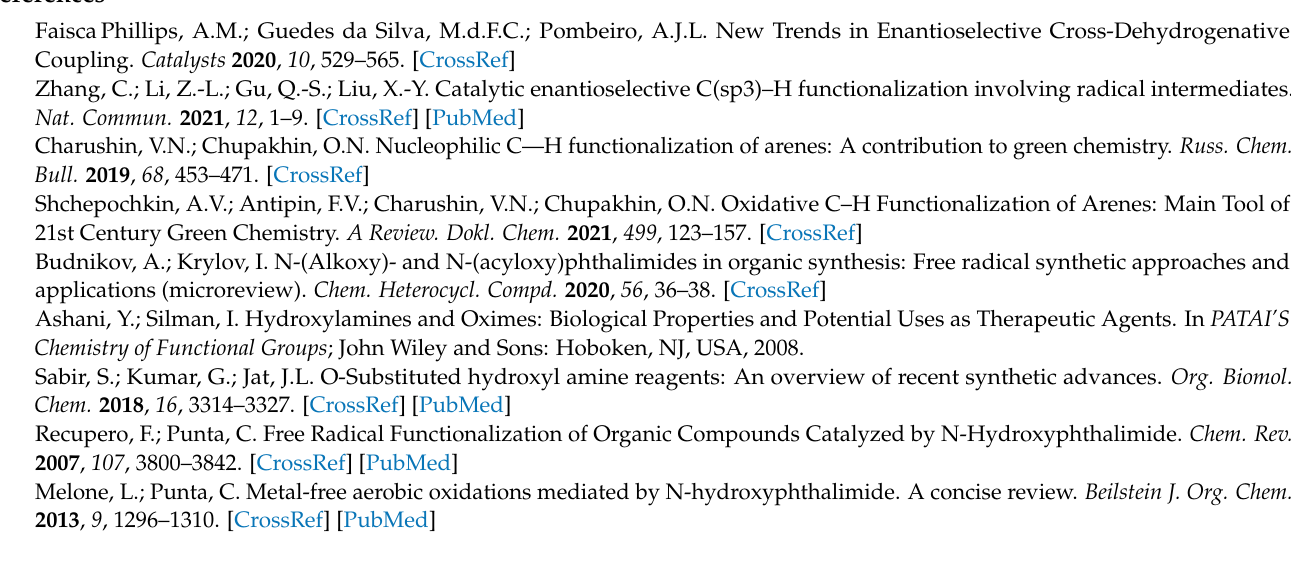
Figure S3: HRMS (ESI) of 3 , Figure S4: FT-IR spectra of 3